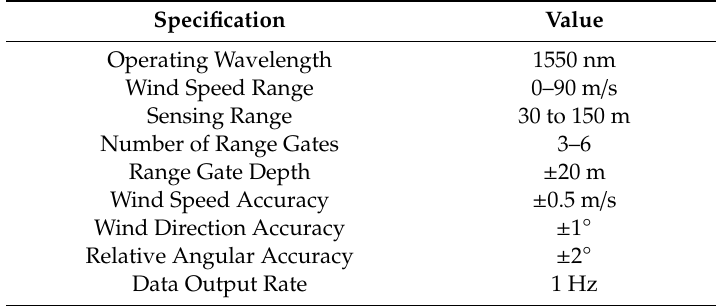
Table 2. Specifications for the Vindicator laser wind sensor of the FLiDAR 6M floating LiDAR device.